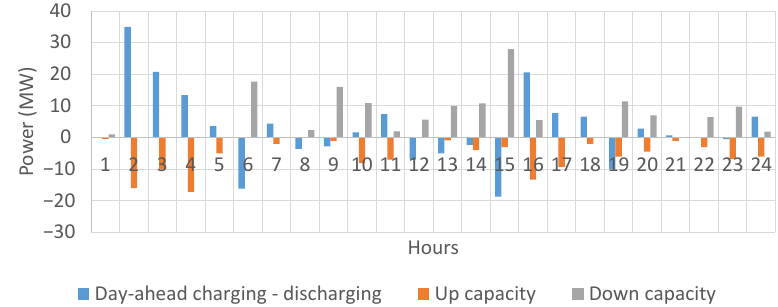
− q dis ) and up/down cleared reserve capacity q dis t t